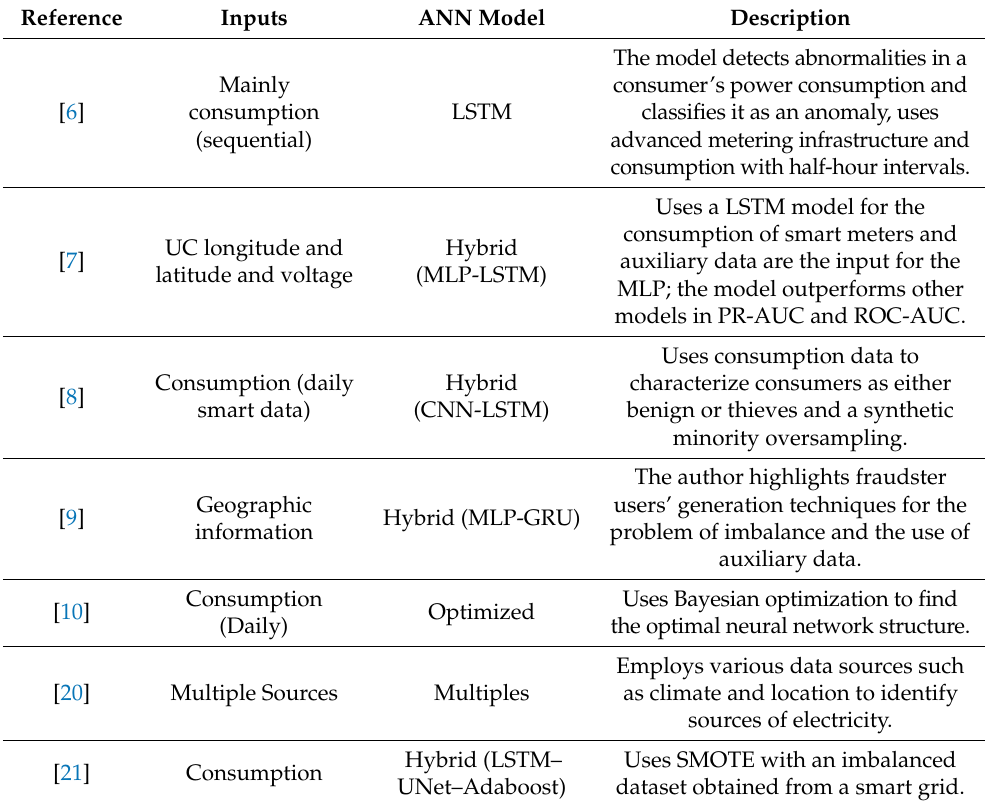
Table 1. Summary of references related to the identification of